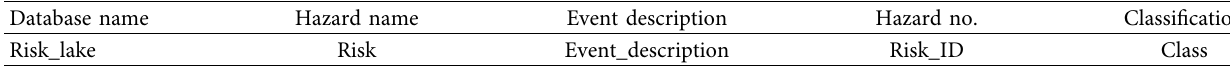
Table 3: Database field remarks.